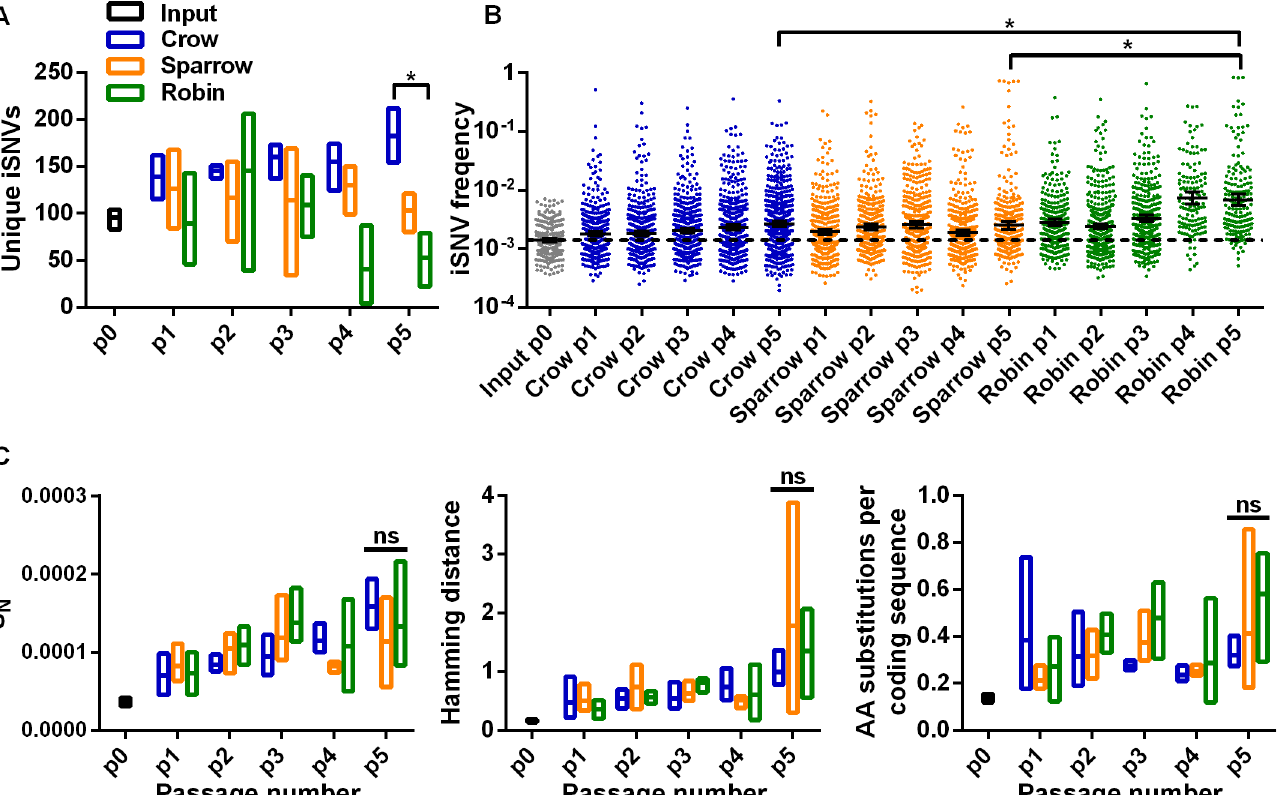
Fig 2. Disparate adaptive routes in birds lead to similar overall intrahost population complexity and diversity. The number ( A , mean ± range) and frequency ( B , geometric mean ± 95% CI) of unique intrahost single nucleotide variants (iSNVs,) from the WNV coding sequence during passage in wild- caught crows, sparrows or robins ( * , P < 0.05, Kruskal-Wallis test with Dunn ’ s correction). ( C ) Mean ( ± range) normalized Shannon entropy (S N , measure of population complexity) (left), Hamming distance from the p0 consensus sequence (SNVs per coding sequence) (middle) and the number of amino acid (AA) substitutions per coding sequence (right) (ns, not